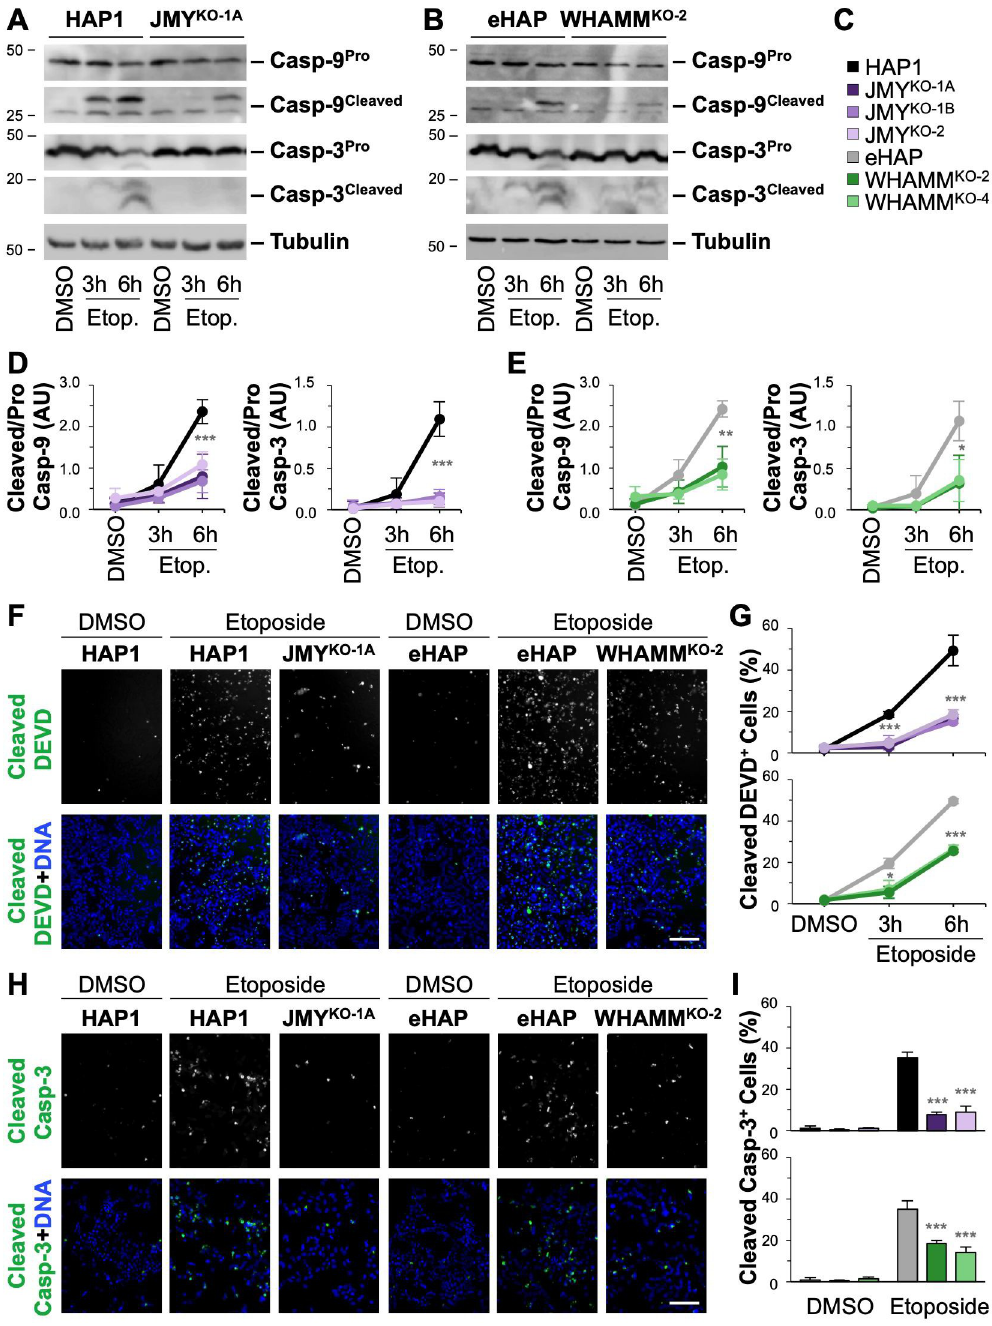
Fig 3. Initiator and executioner caspase cleavage is inefficient in the absence of JMY or WHAMM. (A-B) HAP1, JMY KO , eHAP, and WHAMM KO cells were treated with DMSO for 6h or 5 μ M etoposide for 3h or 6h, and extracts were immunoblotted with antibodies to caspase-9 (Casp-9 Pro and Casp-9 Cleaved ), caspase-3 (Casp-3 Pro and Casp-3 Cleaved ), and tubulin. (C) Key for color-coded samples in panels (D-I). (D-E) For quantification, the caspase cleavage ratio was calculated by dividing the cleaved band intensity by the procaspase band intensity. Each point represents the mean ratio ± SD from 3 experiments. AU = Arbitrary Units. (F) Cells were treated with DMSO or etoposide, and stained with caspase-3/7 green detection reagent to label cleaved DEVD (green) and Hoechst to stain DNA (blue). Images are from the 6h timepoint. Scale bars, 100 μ m. (G) The % of cleaved DEVD-positive cells was calculated in ImageJ by counting cells that exhibited green nuclear fluorescence and dividing by the total number of Hoechst-stained nuclei. Each point represents the mean ± SD from 3 experiments (n = 2,741–6,646 cells per point). (H) Cells treated as above were fixed and stained with an antibody